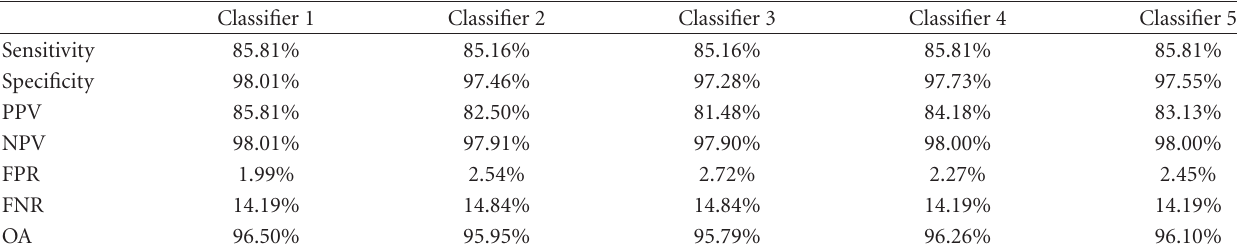
Table 5: Performance of the five LVQ NNs trained and tested for the robustness test (cumulative results for the training and test